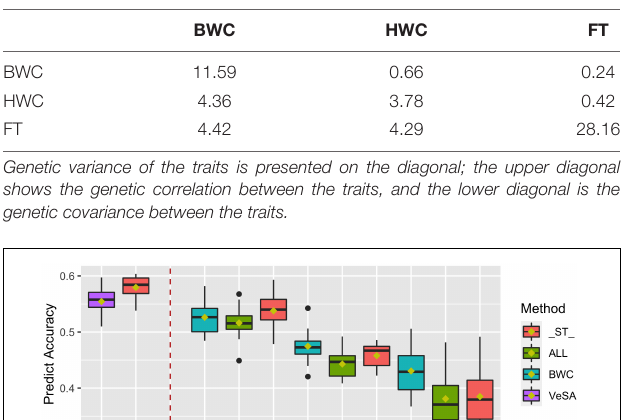
TABLE 2 | MT-GBLUP genetic correlation, genetic variance, and genetic covariance between BWC, HWC, and FT in the temperate ecological zone.